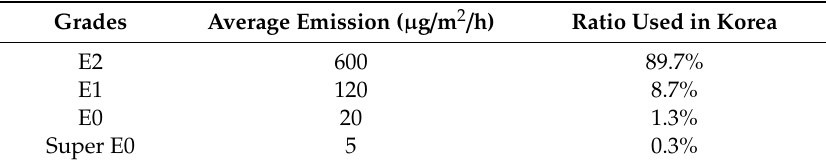
Table 2. Summary of information of MDF